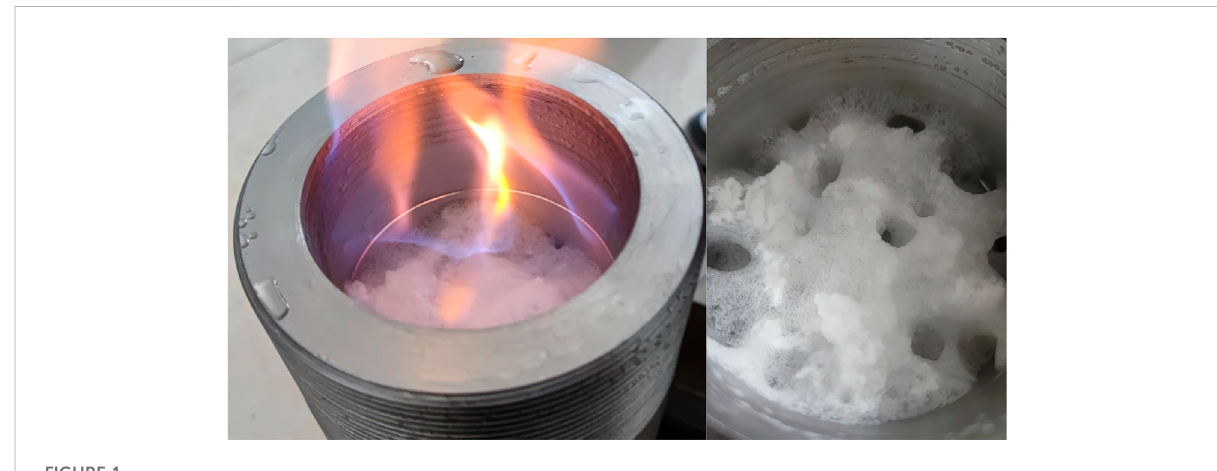
FIGURE 1 Gas hydrate produced in